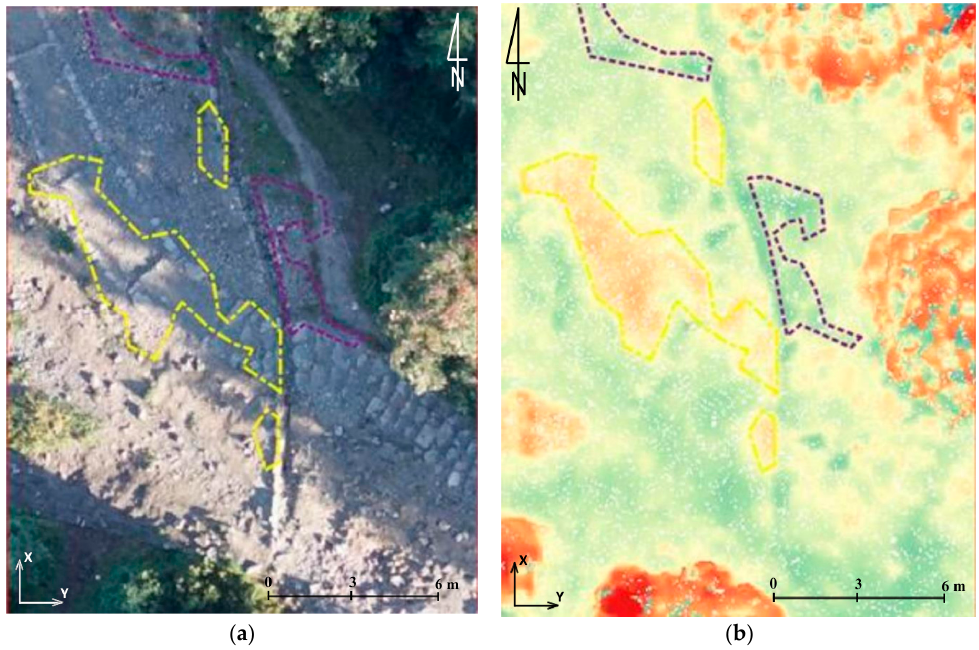
Figure 18. Field C: ( a ) ortophotomap, and ( b ) the results of comparison of DSM UAV–DSM ALS (source: authors’ own study).